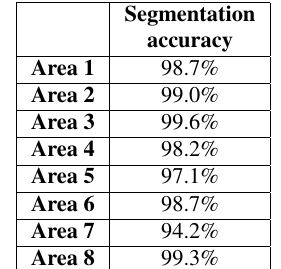
regularisation with the ones from the manual delineation ranges between 94% and 99% (results are presented for each area in Table 9),compared to a matching ≤ 90% after classification. The matching ratio is obtained by comparing the well classified pixel to all labelled pixel in the manual delineation. The improve- ments also concern the homogeneity of the segments delineated automatically. Segmentation results are much less noisy than the classification results. The errors occur at the borders between the delineated stands. There are two kinds of errors: (i) the ones due to the uncertainty of the borders, and (ii) the ones due to is related to the generalisation of our ground truth. The manual and the automatic delineation are performed at the same spatial the stands.